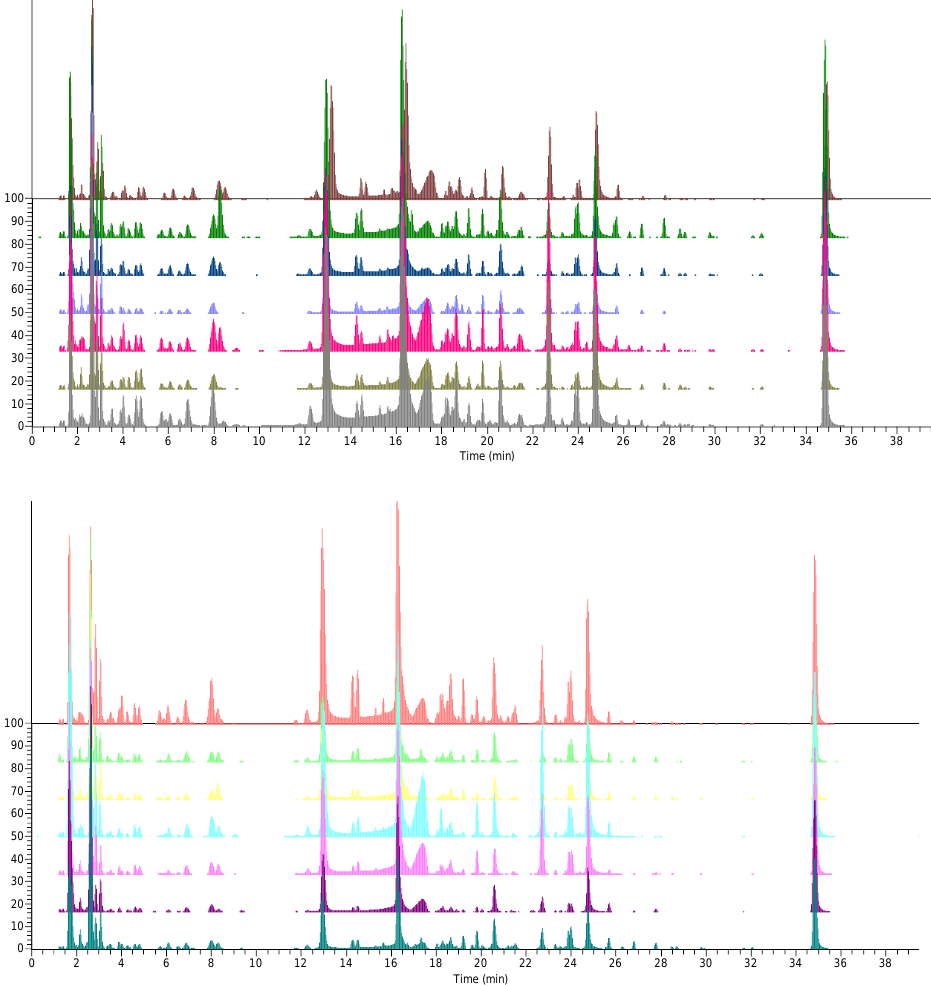
Figure 1. UHPLC-HR-ESI-MS profiles of the fourteen peel samples M1 – M14 (M1 the first up, M-14 the last down) in the negative ion mode.